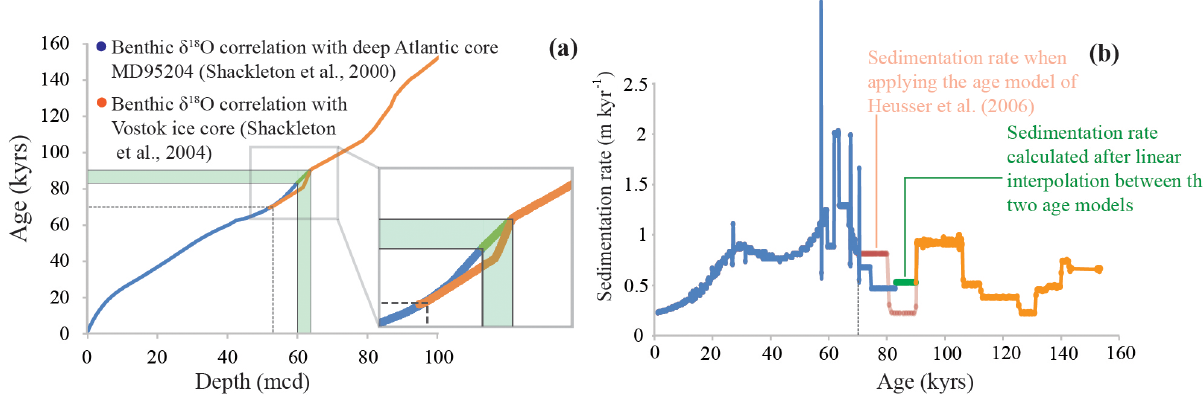
Figure 2. Age–depth relations for ODP 1234 derived from Heusser et al. (2006). (a) Age–depth constraints based on the correlation of benthic δ 18 O with Atlantic core MD95204 (dark blue; upper half) and the Vostok ice core chronology (orange; lower half). Heusser et al. (2006) switched between the two different age models at ∼ 69ka and ∼ 53mcd (dashed line). However, we used the full upper age model and then linearly interpolated between the age models from ∼ 60 to 64mcd, as indicated by the connecting green line. (b) Sedimentation rates were calculated after linear interpolation between the age–depth tie points of the two age models. The sedimentation rates calculated after the linear interpolation between the age models are presented in green. In transparent red, the sedimentation rates are plotted when applying the dating strategy of Heusser et al.